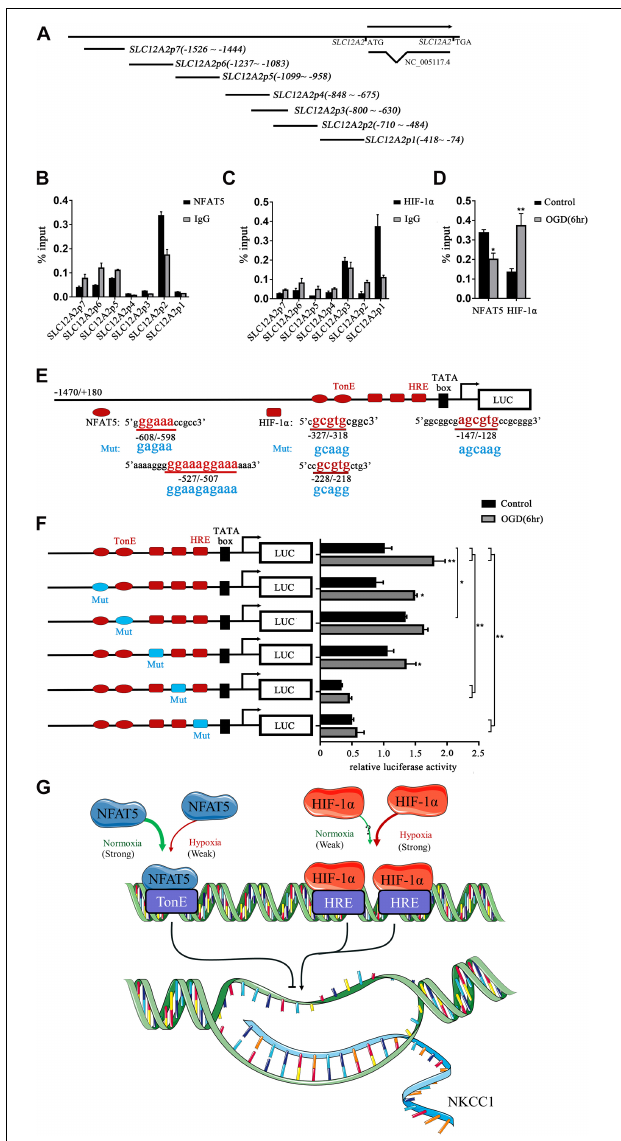
FIGURE 5 | NFAT5 and HIF-1 α transcriptional regulation of NKCC1. (A) Illustration of the primer sets at the NKCC1 promoter used in the ChIP assays. (B,C) Enrichment of NFAT5 and HIF-1 α at the NKCC1 promoter region was determined by the primers shown in Supplementary Table S1 . ChIP-qPCR data were normalized by the percent input method. (D) ChIP assays of NFAT5 and HIF-1 α in the presence or absence of OGD. Hippocampal neurons were collected for ChIP assay at 6 h after OGD. ChIP-qPCR data were normalized using the fold enrichment method (ChIP signals were divided by IgG signals). (E) Prediction of NFAT5- and HIF-1 α -binding sites in the NKCC1 promoter and mutation sites of